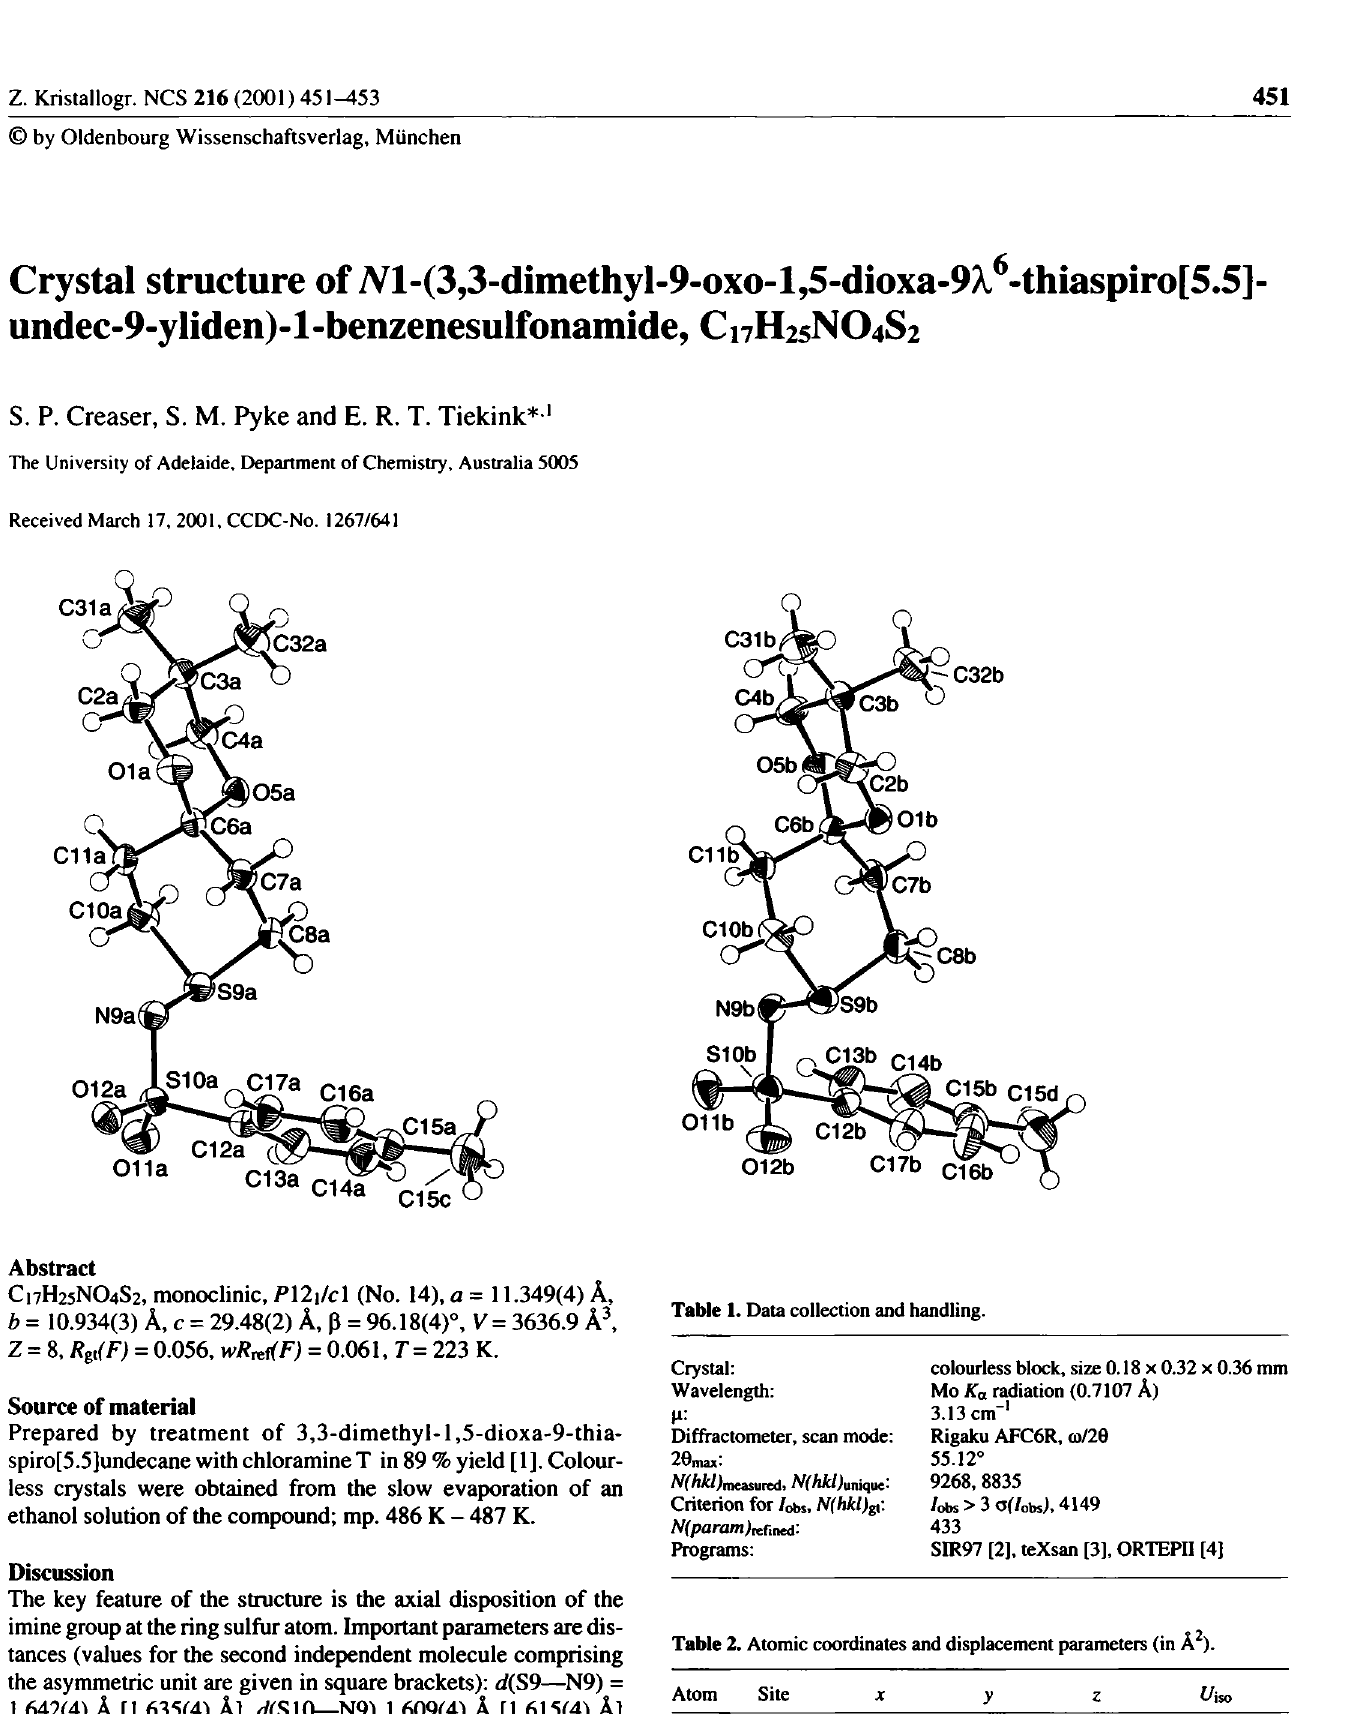
Table 2. Atomic coordinates and displacement parameters (in A 2